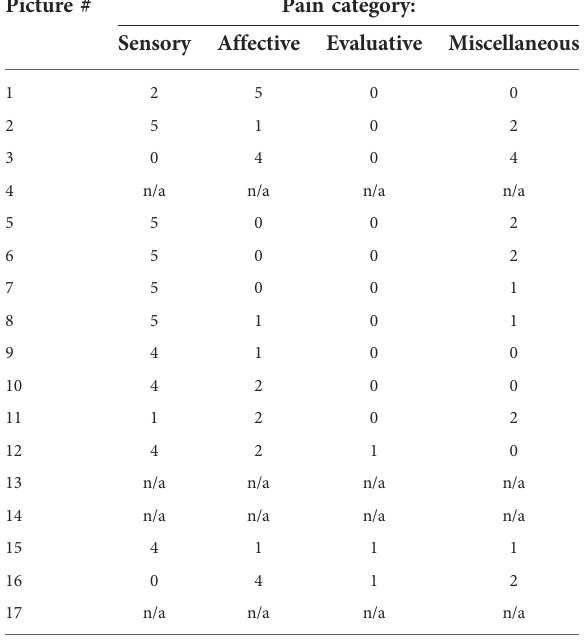
TABLE 2 Illustration assignment to pain category by rater